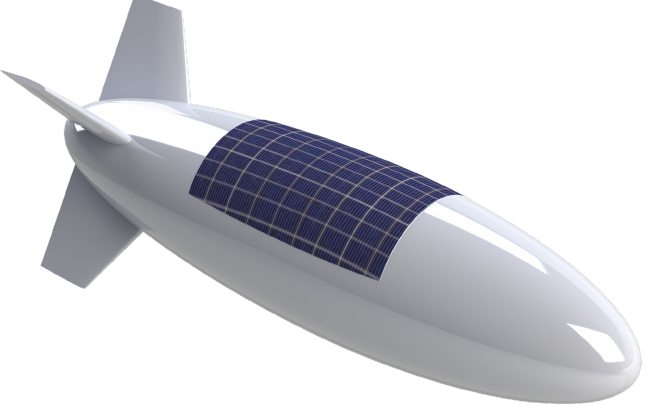
Figure 12. Airship with solar